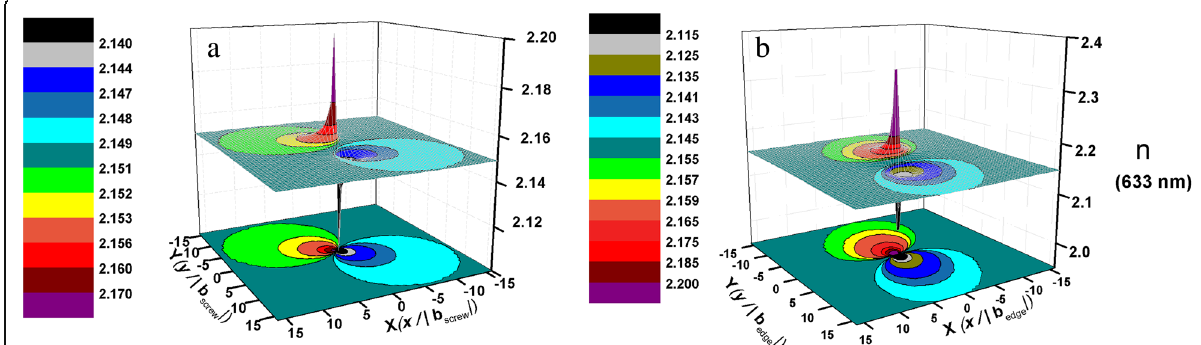
Fig. 4 The distribution of refractive index at 633 nm around a unit screw dislocation and b unit edge dislocation